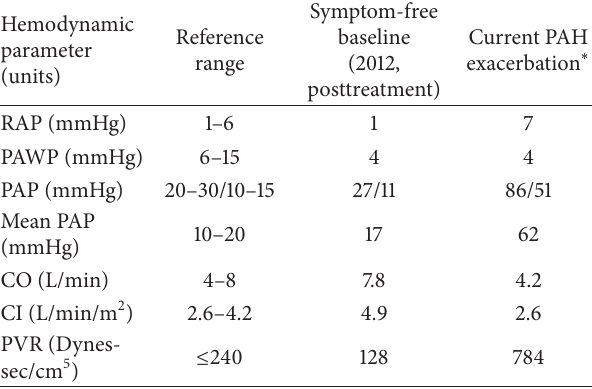
Table 3: Hemodynamic parameters from right heart catheterization of the patient after successful treatment of 2012 episode of PAH comparedtothecurrentpresentationofseverePAHandcardiogenic